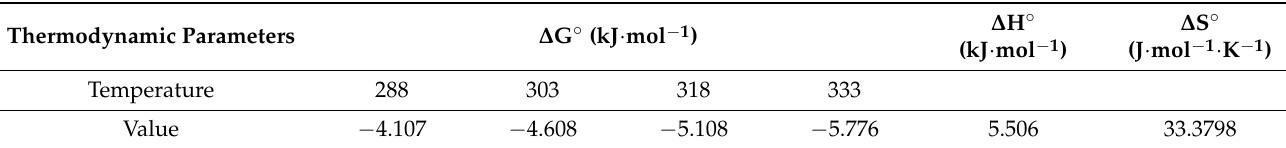
Table 7. Thermodynamics parameters for the adsorption of acid tannic on steel slag.